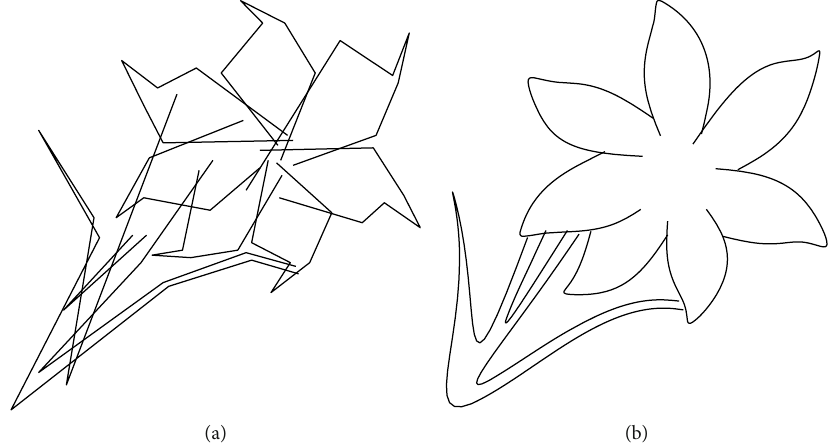
Figure 5: Application of R